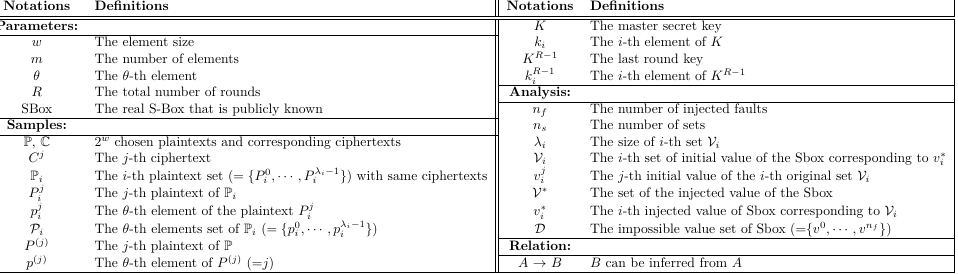
Table 2 defines the notations used in this paper. Table 2: Notations used in this